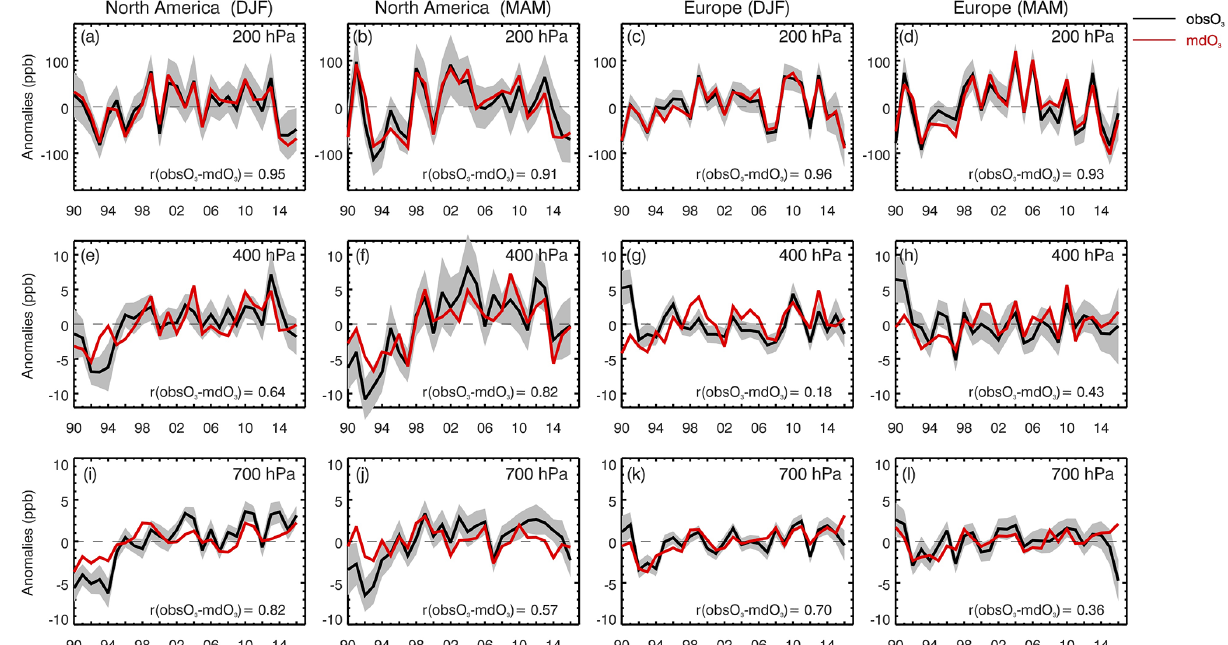
Figure 2. Time series plots of observed (black) and simulated (red) ozone anomalies (unit: ppb) at 200hPa (top), 400hPa (middle) and 700hPa (bottom) averaged from selected ozonesonde sites over North America and Europe in winter and spring seasons from 1990 to 2016. The anomalies are calculated by removing the seasonal mean averaged from 1990 to 2016. The shaded area represents the 95% confidence interval (CI) of observed mean, which is calculated by multiplying the standard error of observations by